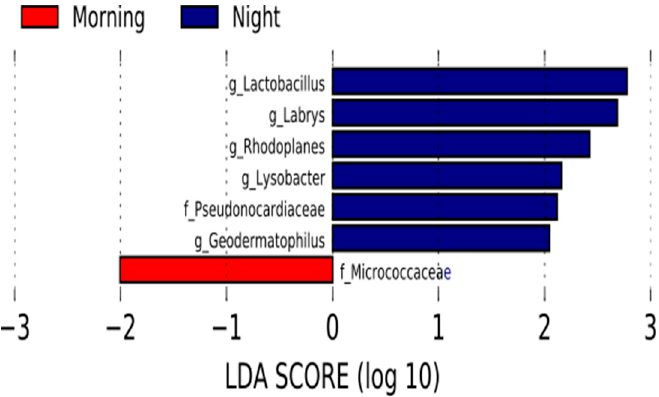
Figure 2. Represented significant bacterial taxa for each time of the day. Linear discriminant analysis (LDA) effect size (LEfSe) comparison of bacterial taxa between human milk morning samples and night samples. Horizontal bars represent the effect size for each taxon: red indicates taxa enriched in the morning group and blue indicates taxa enriched in the night group. LDA score cutoff of